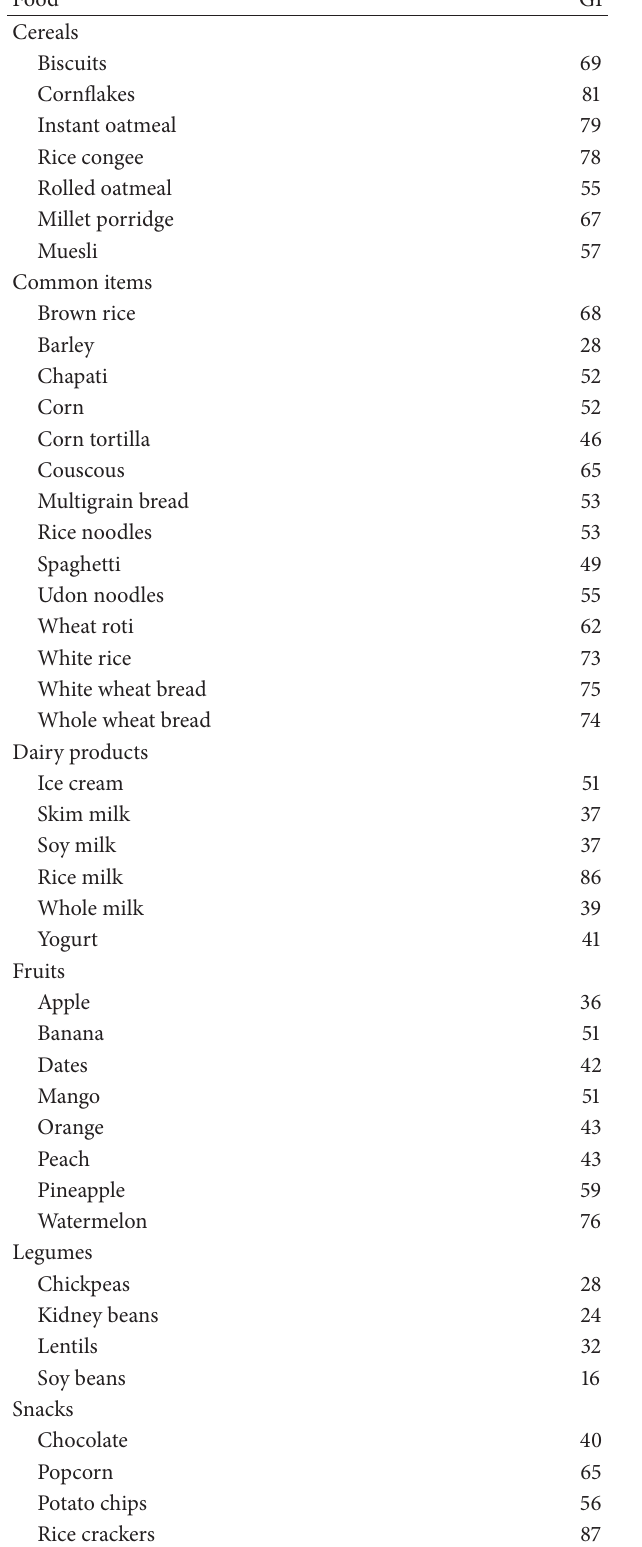
Table 2: Common carbohydrate foods and their glyceamic indices (GI).